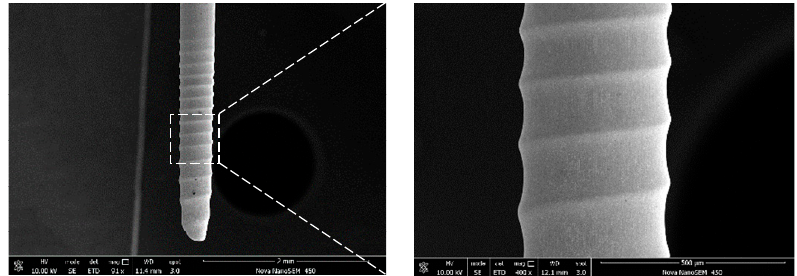
Figure 10. The typical spiral cylindrical microelectrode.